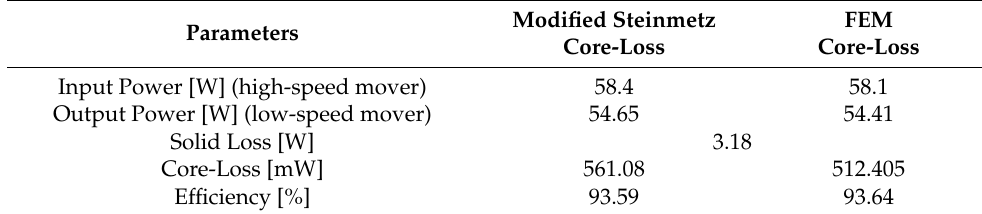
Figure 8. FEM and experiment comparison results—( a ) Pull-out force of the high-speed mover, ( b ) pull-out force of the low-speed mover, ( c ) displacement amount of the high-speed mover, and ( d ) displacement amount of the low-speed mover. Table 3. Analysis results of the linear magnetic